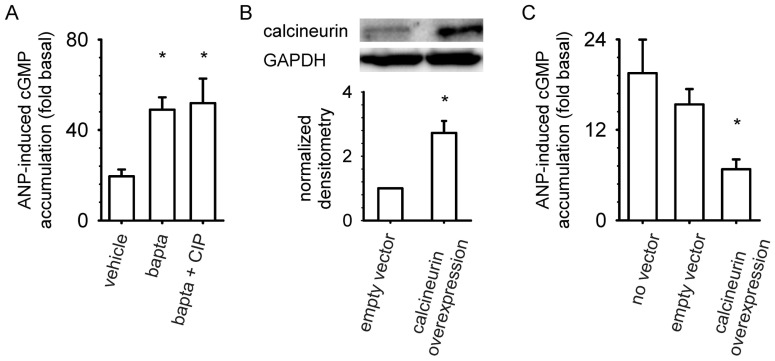
Calcineurin modulates ANP-induced cGMP accumulation in MA-10 cells.(A) Cells pretreated with 50 µM bapta-AM displayed marked increases in ANP-induced intracellular cGMP accumulation compared to control cells. Pretreatment with CIP and bapta-AM did not further potentiate the response. (B, C) Cells transfected with plasmids encoding calcineurin displayed increased calcineurin levels (B) and lower ANP-induced cGMP accumulation (C) compared to cells transfected with empty vector. Neither pretreatment with bapta-AM nor overexpression of calcineurin significantly altered the basal cGMP level. Experiments were conducted in the presence of 500 µM IBMX. * P<0.05. Data are from at least three experiments.